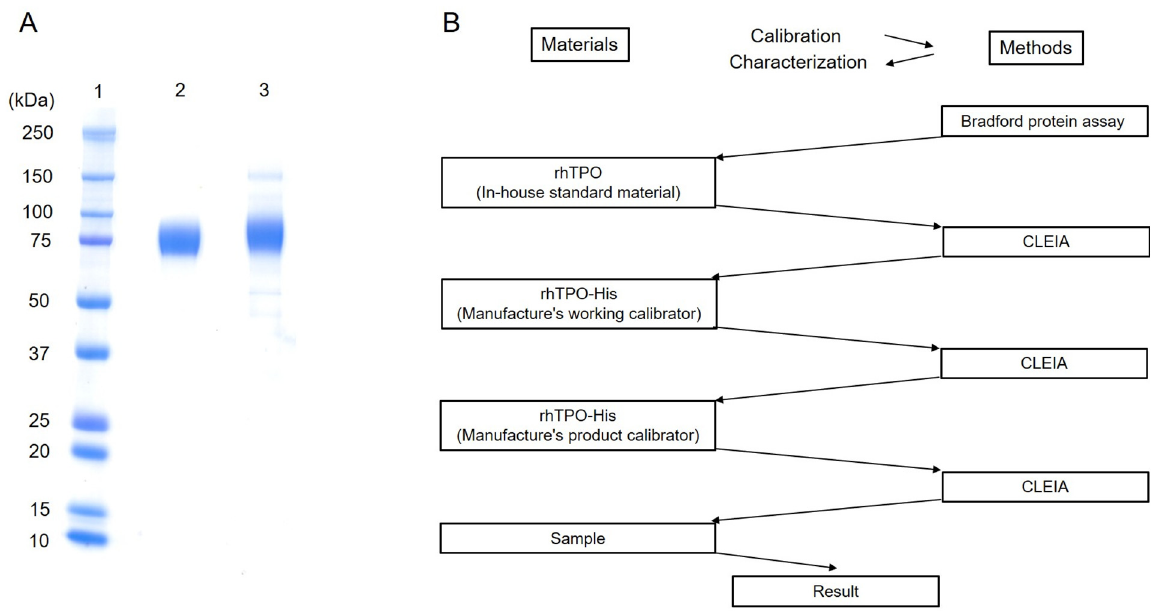
Figure 2. Comparison of purity levels between the isolated rhTPO-His and rhTPO as in-house standard material and traceability system diagram using these materials. ( A ) The samples in lanes 1–3 were subjected to SDS-PAGE. Lane 1, prestained molecular mass markers (Bio-Rad) of indicated size (kDa); 2, rhTPO as in-house standard material; 3, isolated rhTPO-His. Note: 1 μ g of total protein was loaded in lanes 2–3. ( B ) Traceability of thrombopoietin (TPO) concentration was ensured by the new CLEIA assay using BSA standard and the Bradford protein assay. BSA, bovine serum albumin; CLEIA, chemiluminescent enzyme immunoassay; rhTPO, recombinant human thrombopoietin.